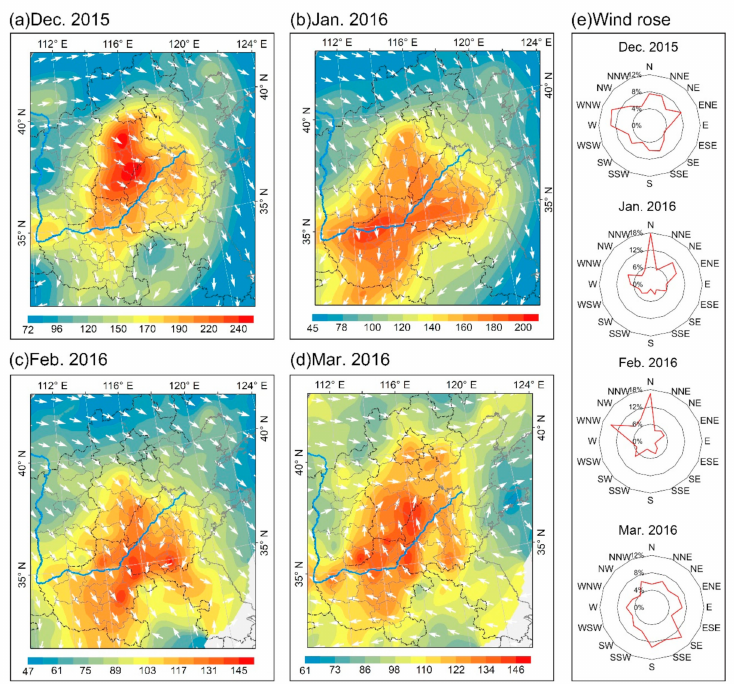
Figure 10. ( a – d ) Spatial distribution of AQI and overlay of the near ground wind field in North China from December 2015 to March 2016, and ( e ) shows wind roses showing the trajectory of maximum wind speed of major cities of North China from December 2015 to March 2016. The wind field data is derived from the National Centers for Environmental Prediction (NCEP) reanalysis data with a resolution of 2.5 ◦ × 2.5 ◦ (ftp: // ftp.cdc.noaa.gov / Datasets /